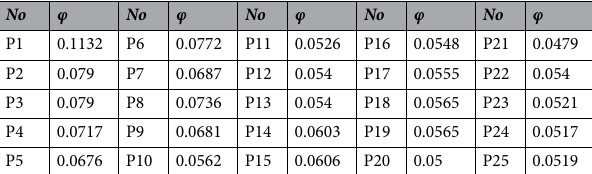
Table 5. Robustness of the 25 generations of product structural